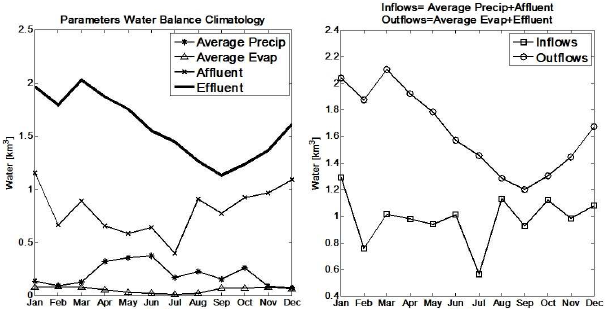
Fig. 7. Mean monthly water balance. (A) Inflows from rivers (- × -) and precipitation (- ∗ -), outputs from evaporation (- M -) and Rio Baker ( — ) . (B) Total inflows (- ⁄ -) and outflows (- ◦ -).